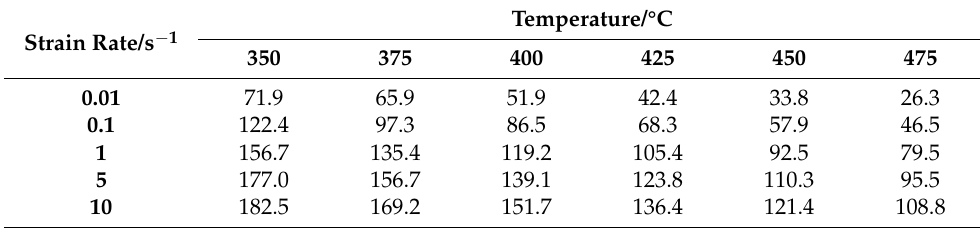
Table 2. Data filtration for peak stress